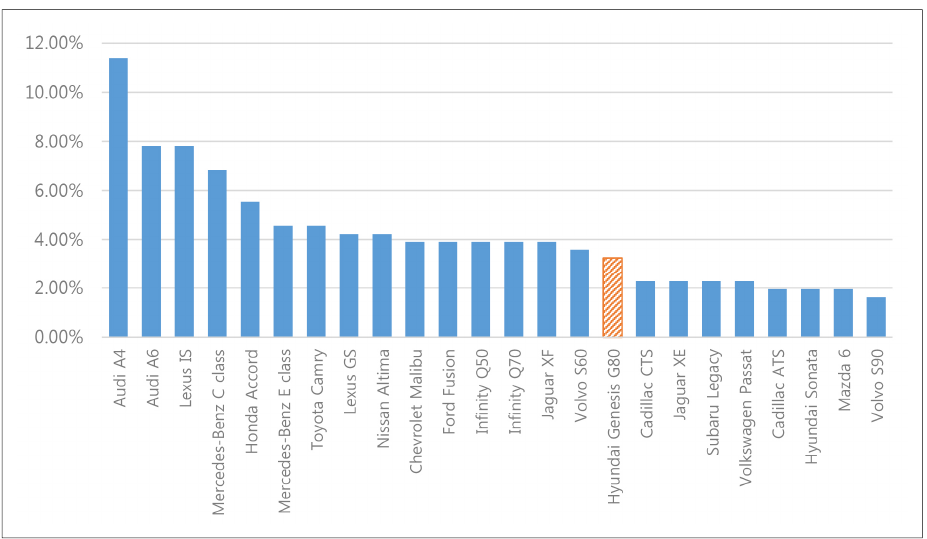
<Figure 7> Frequencies of brands compared with BMW